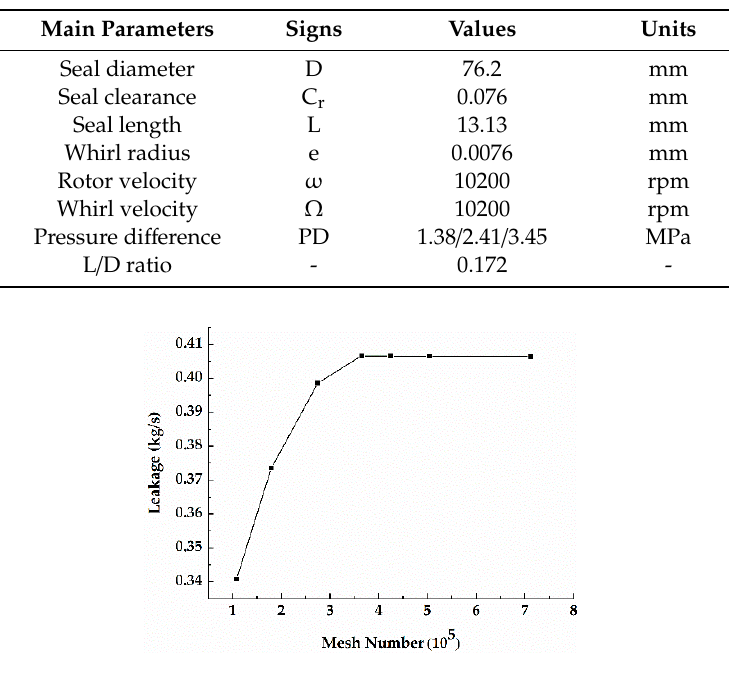
Figure 3. Grid independency analysis.